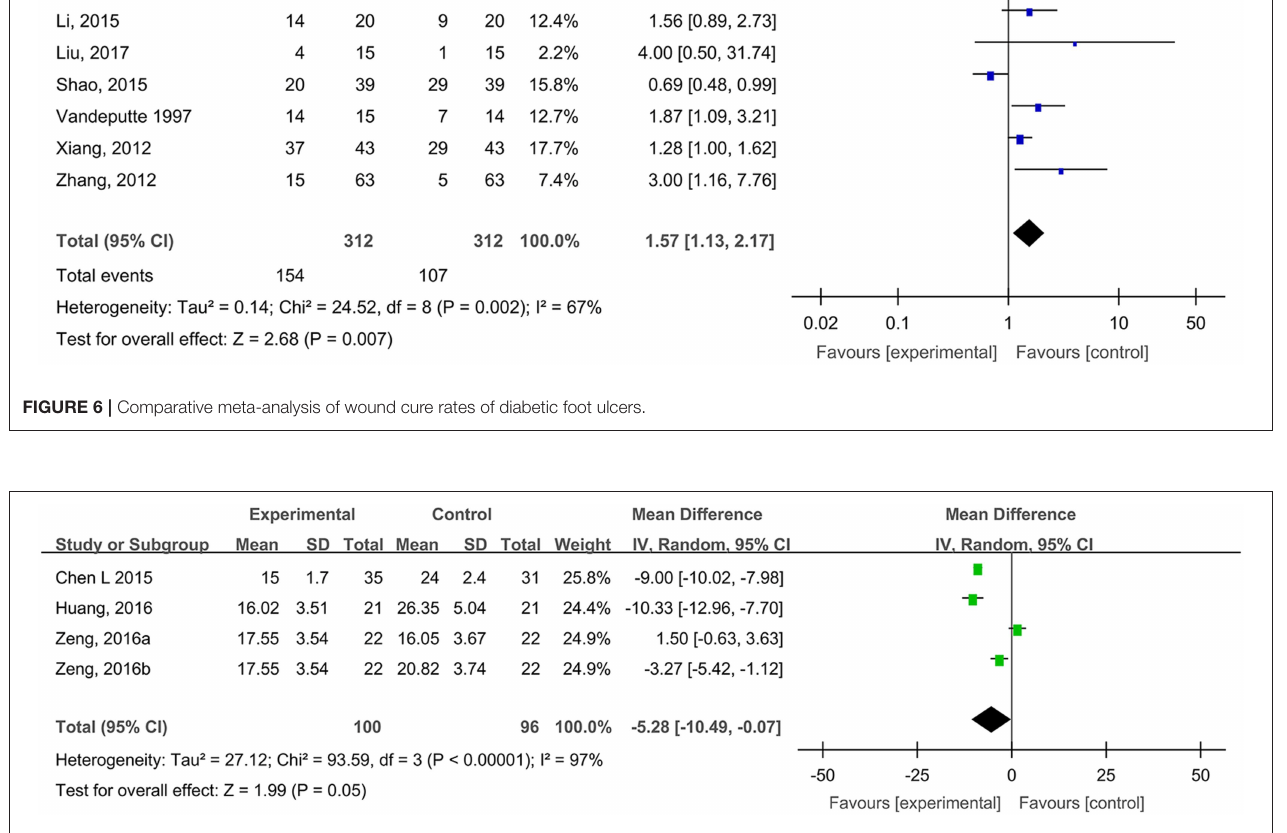
FIGURE 7 | Comparative meta-analysis of healing times of traumatic skin injuries.